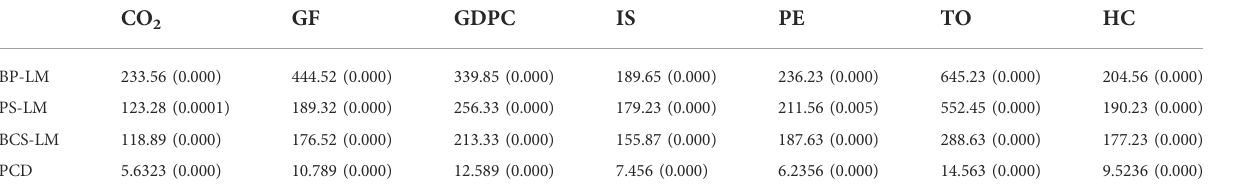
TABLE 3 Cross-section dependence test.